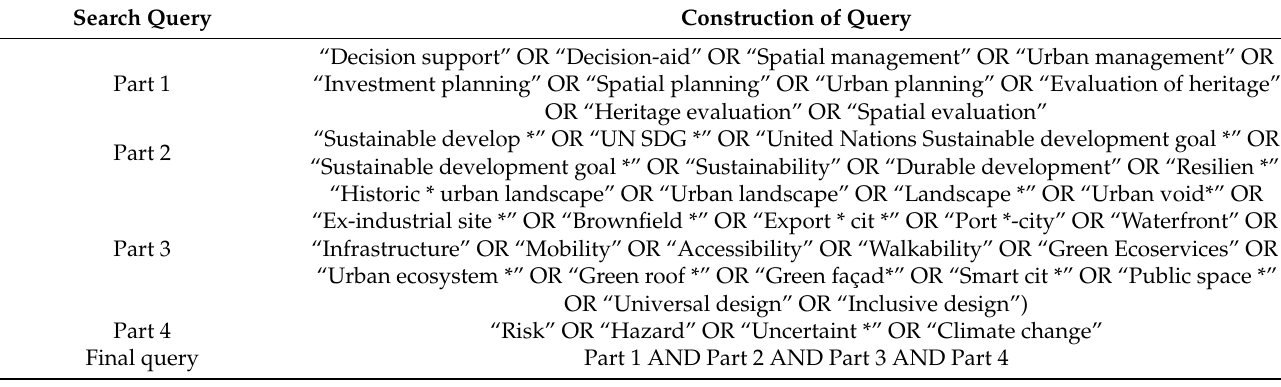
Table 4. The search query used in both Scopus and WoS